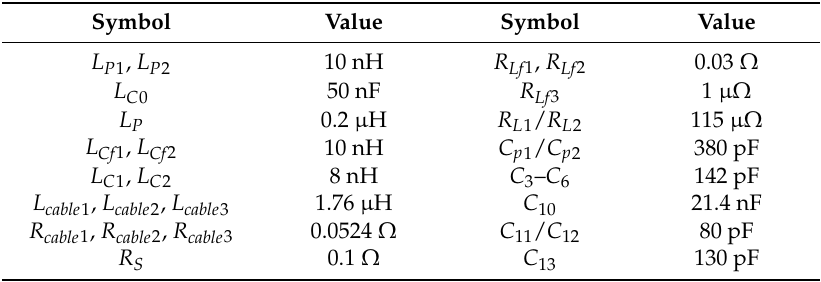
Table 3. Parasitic parameters of WCS.